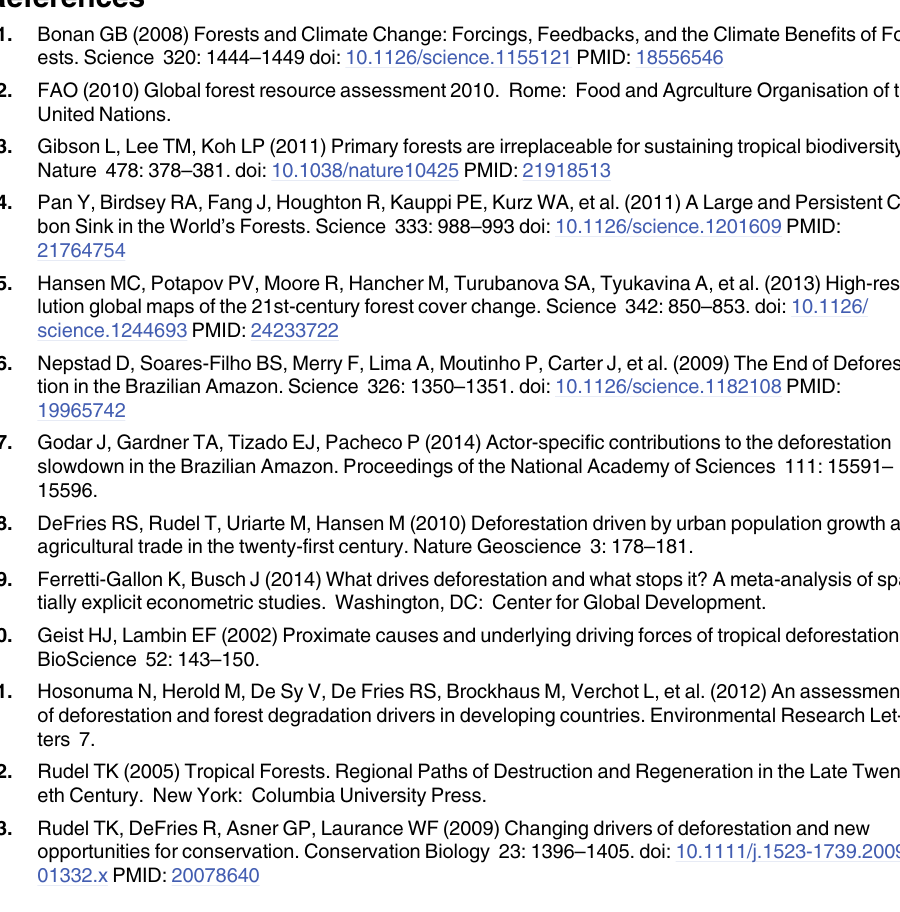
S1 Table. Socio-economic data at country level. Socio-economic data used in the WLS regres- sion analysis. S2 Table. Country level results. Forest extent and forest loss results presented at country